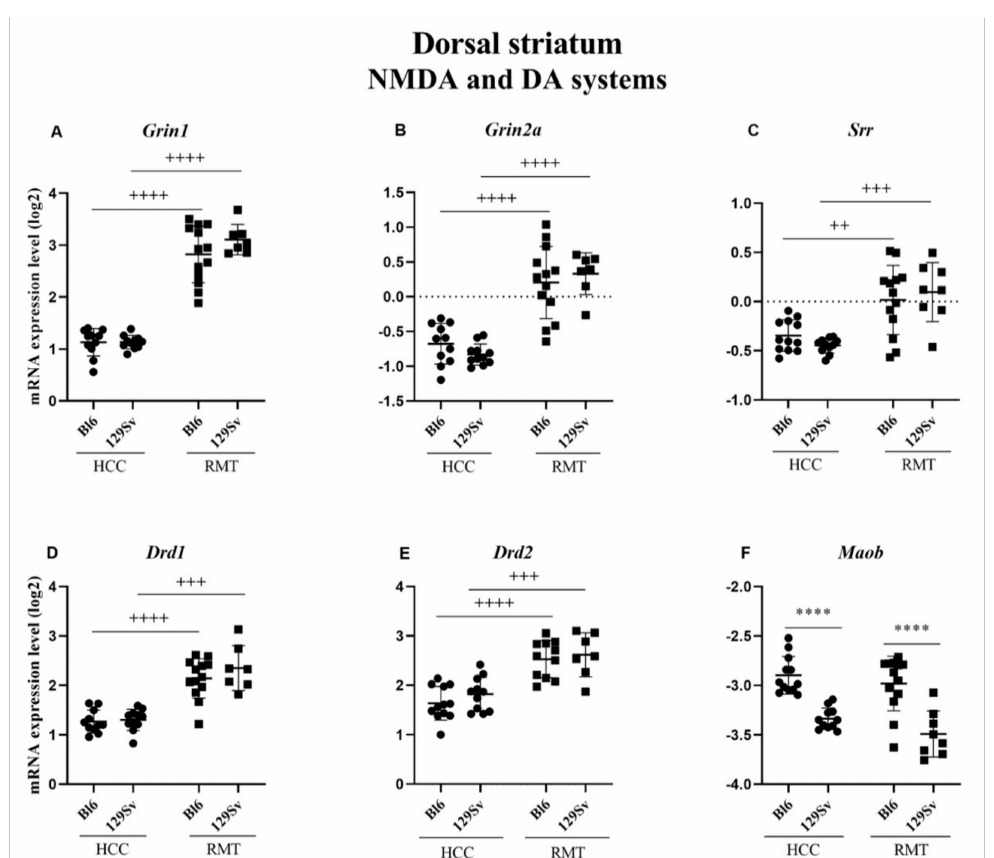
Figure 9. NMDA and DA systems gene expression in dorsal striatum of Bl6 and 129Sv mice. Two-way ANOVA was applied to demonstrate differences between the strains and environments. Substantial statistically significant gene expressions for ( A ) Grin1 —glutamate ionotropic receptor NMDA type subunit 1, ( B ) Grin2a —glutamate ionotropic receptor NMDA type subunit 2A, ( C ) Srr —serine racemase, ( D ) Drd1 —dopamine receptor D1, ( E ) Drd2 —dopamine receptor D2 and ( F